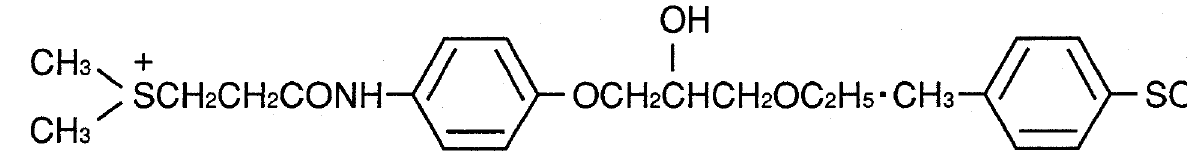
FIG. 1. Chemical structure of suplatast tosilate